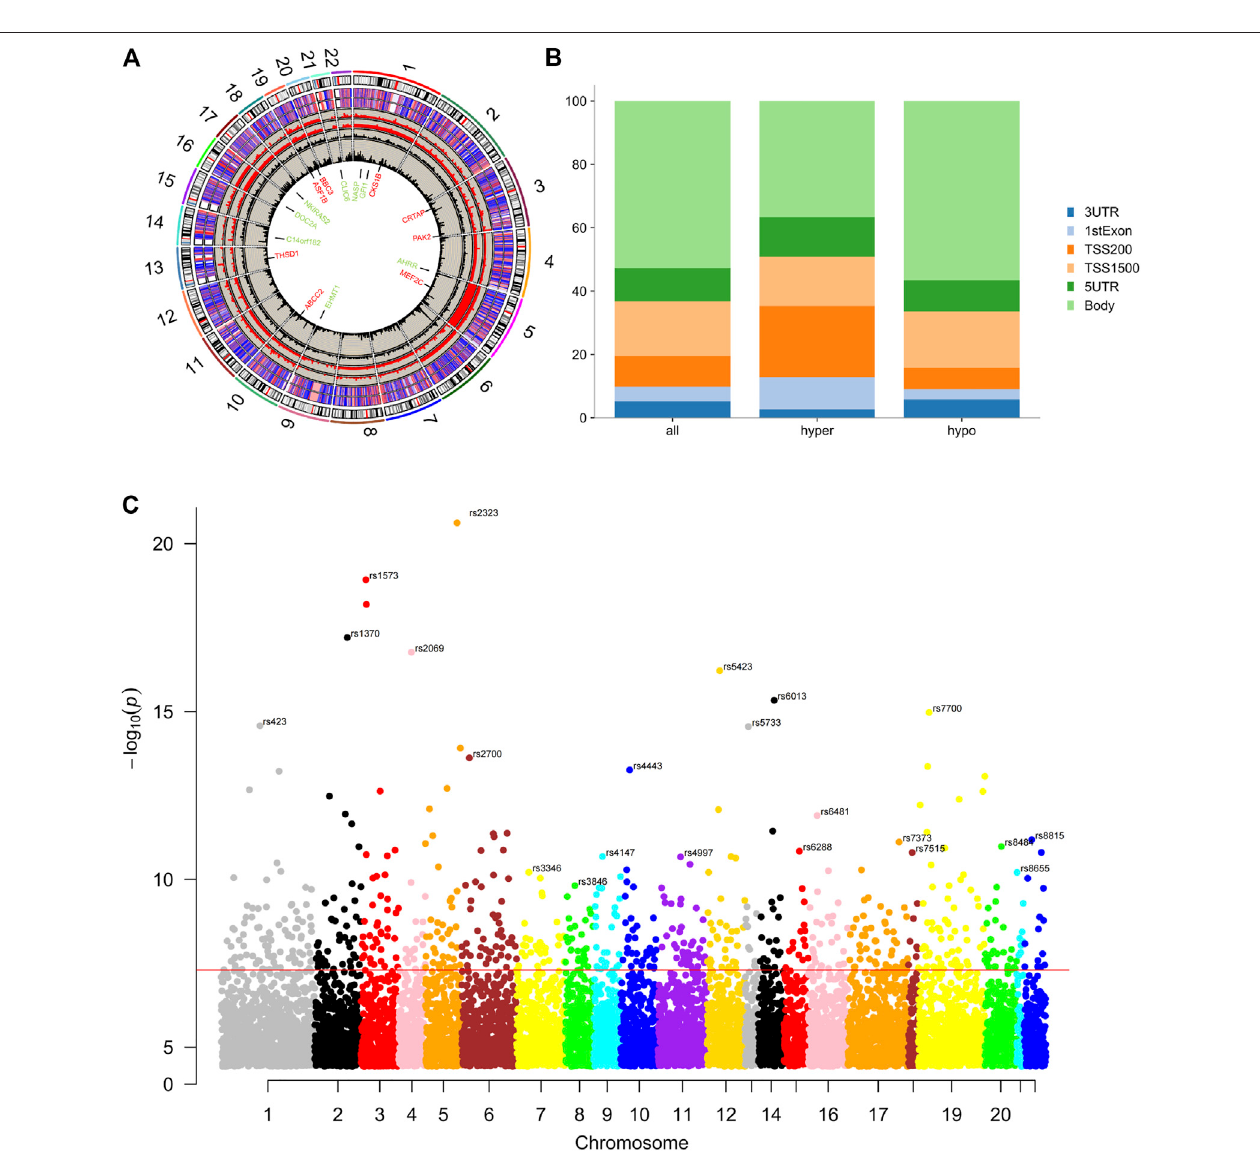
FIGURE1| Differential DNA methylation distribution. (A) , Circus plot of CpGs. Autosomal chromosomes are shown in a clockwise direction from 1 to 22 in the outermost circle. Chromosomes X, Y were excluded from the analysis. Red and green-labeled genes correspond to the top 8 hypermethylated and hypomethylated genes, respectively. The two innermost circles represent the frequency of the fi ltered hypermethylated (inner) and hypomethylated (outer) CpG islets. The two middle circles demonstrate the histogram of p values of hypermethylated (inner) and hypomethylated (outer) CpG islets. The two outermost circles show the heat maps with two different sample sets of methylated CpG islets. (B) , Bar plot of differentially methylated CpGs throughout each genomic region. The body methylated CpG islets were excluded for further analysis. (C) , Manhattan plot of epigenome-wide association results showing − log 10 ( p -value) labeled with the red